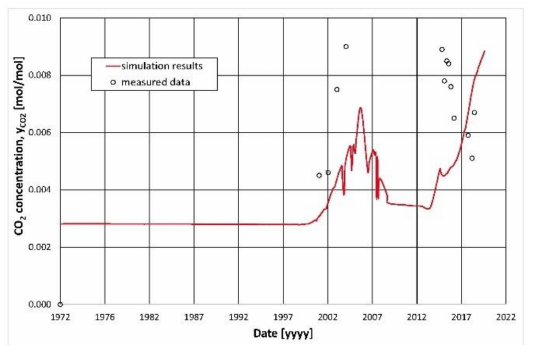
Figure 19. Model calibration. Comparison of measured CO 2 concentration and simulation results in gas produced by well W4.